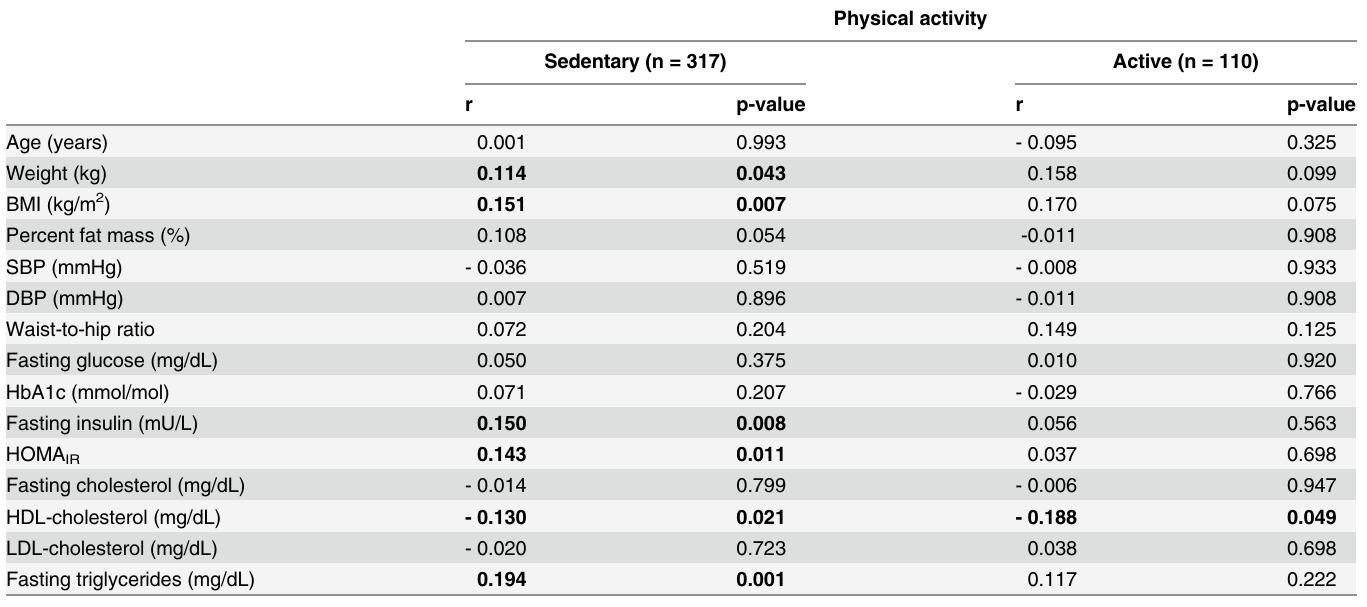
Table 2. Bivariate correlation among circulating irisin levels and anthropometric and clinical parameters according to self-reported leisure time physical